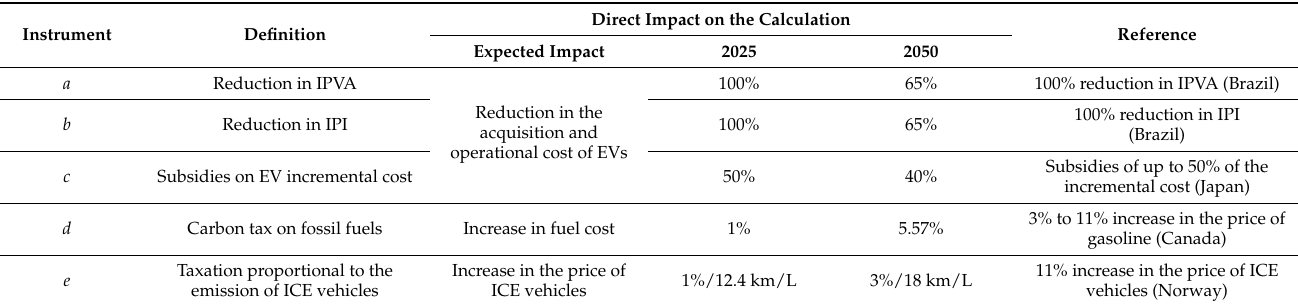
Table 2. Proposed public policies to promote EV participation in the transportation